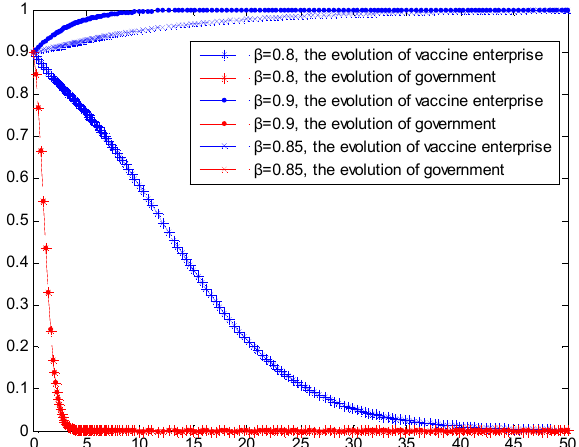
Figure 5. Simulation results of the evolutionary game between the two parties under the circumstance that the success rate of government passive supervision is increased.